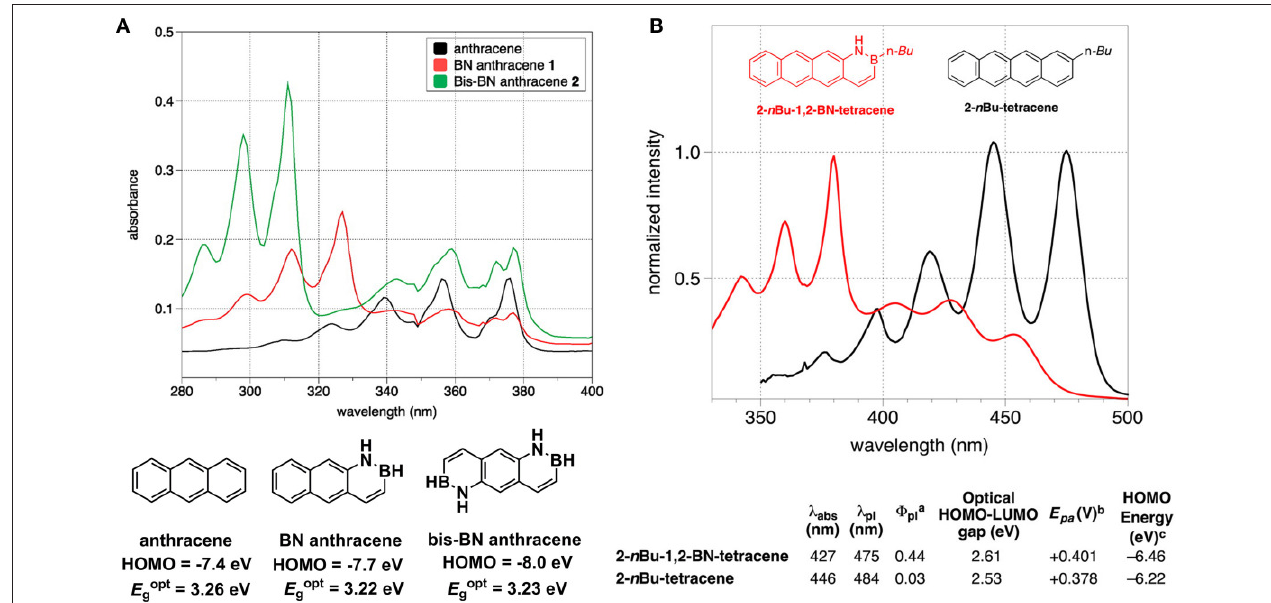
FIGURE 12 | Absorption and energy levels of anthracene and B-N embedded anthracene (A) and tetracene and B-N embedded tetracene (B) . Reprinted with permission from Ishibashi et al. (2014, 2017). Copyright (2014, 2017) American Chemical Society.